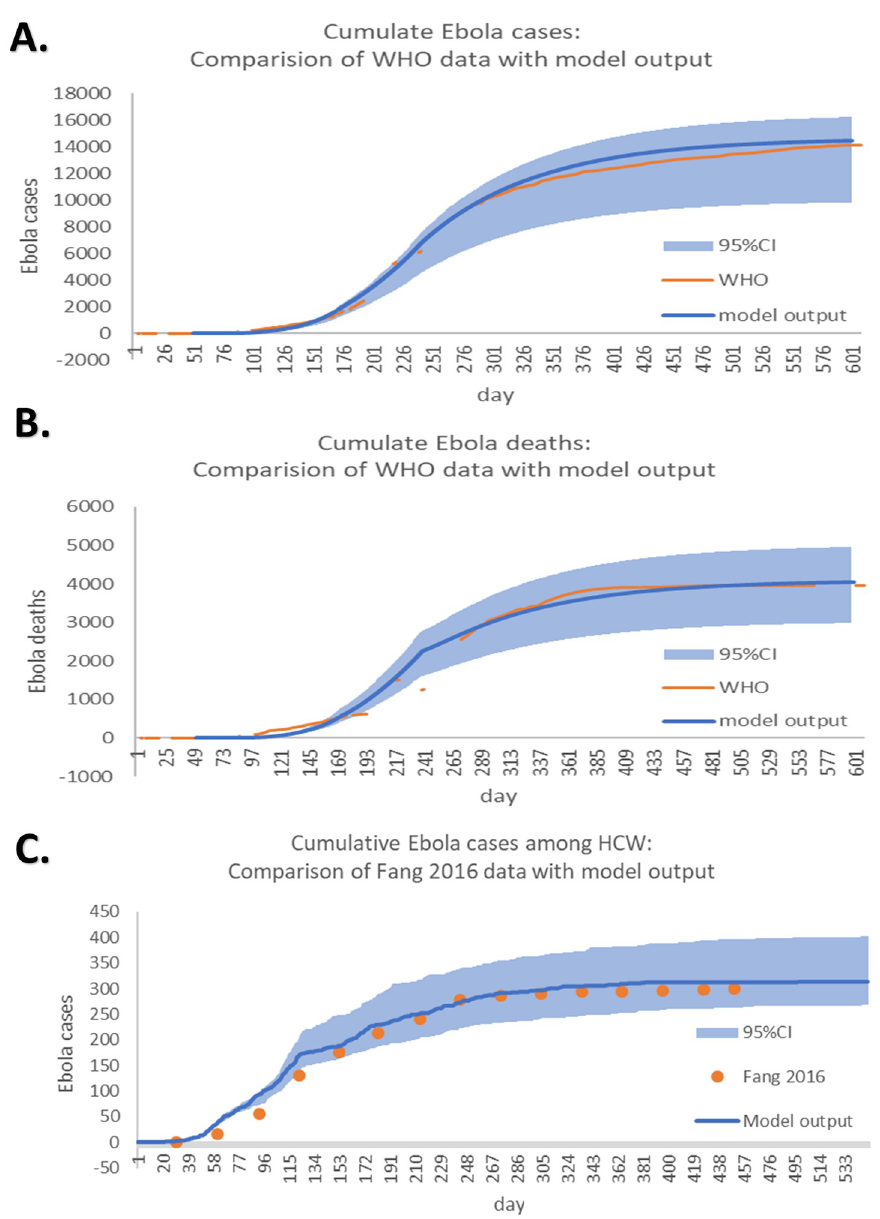
Fig 6. Comparison of the output of the simulation result with published data. A: Comparison of cumulative Ebola cases reported by the WHO with model output. B: Comparison of cumulative Ebola mortality reported by the WHO with model output. C: Comparison of cumulative HCW Ebola cases reported by Fang et al. with model